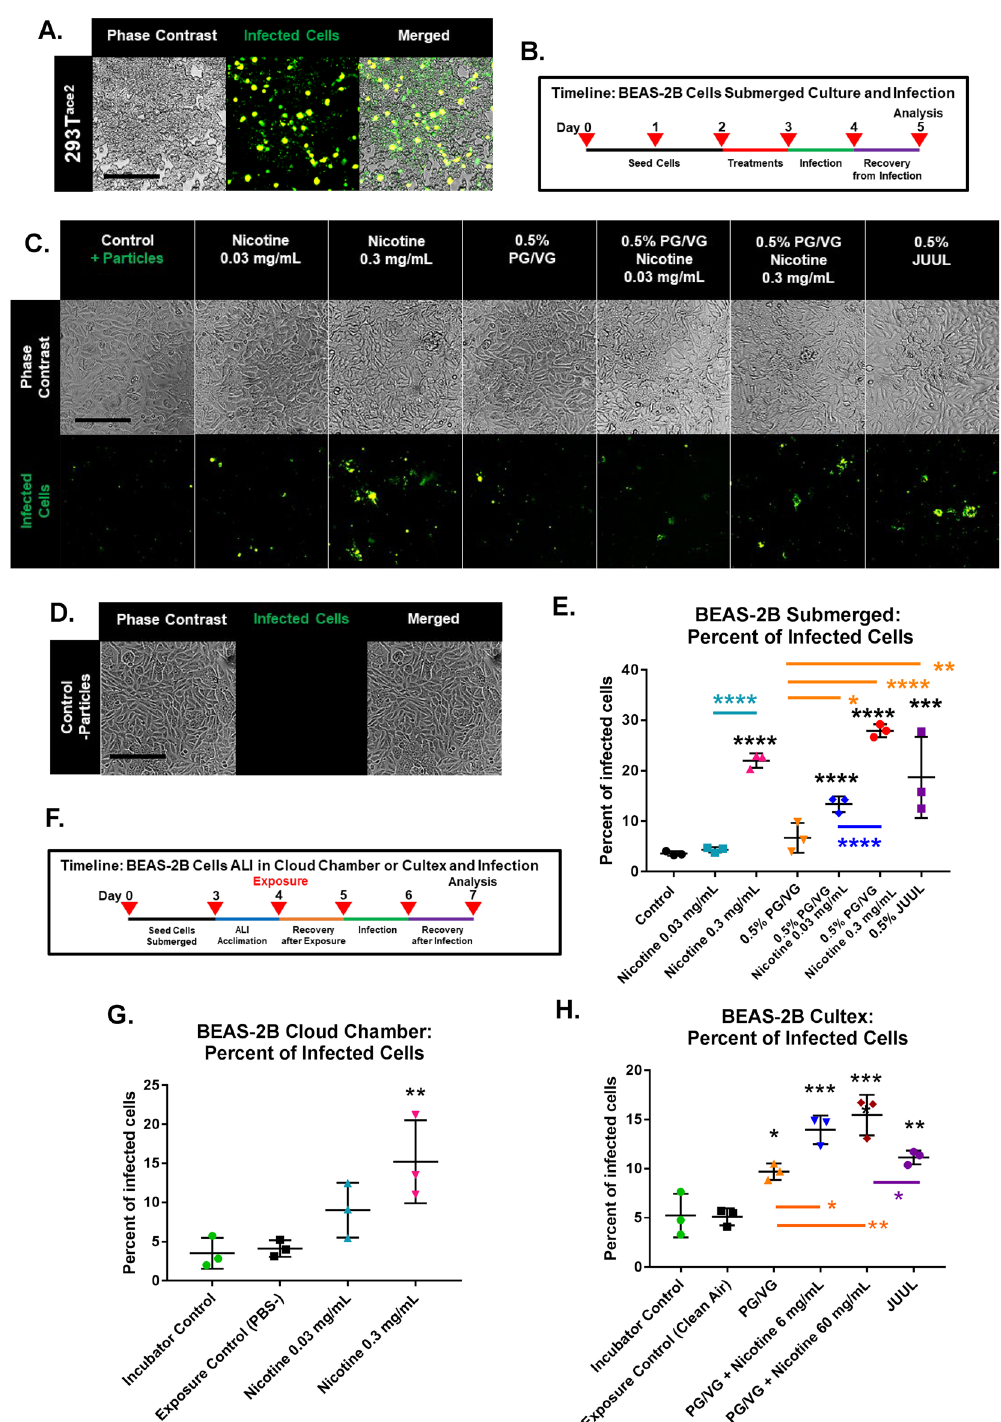
Figure 4. JUUL aerosols and nicotine increased infection after submerged treatment or ALI exposure to aerosols. ( A ) 293T ACE2 cells infected by SARS-CoV-2 viral pseudoparticles. Infected cells express ZsGreen. Scale bar = 250 µm. ( B ) Experimental treatments in submerged culture followed by infection. ( C–E ) Micrographs and flow cytometry showing infection of cells treated 24-h with EC chemicals or JUUL fluid then infected for 24 h. ( C, D ) Micrographs showing ( C ) cells infected with pseudoparticles and ( D ) uninfected cells. ( E ) Percent of infected cells determined by flow cytometry. Scale bars in C and D = 250 µm. ( F ) Experimental treatment used with cells exposed at the ALI in a cloud chamber or a Cultex system, then infected with viral pseudoparticles for 24 h. ( G ) Percent of infected cells after cloud chamber exposure to 1 puff of PBS (control), 0.03 mg/mL nicotine, or 0.3 mg/mL nicotine, followed by 24 h of exposure to pseudoparticles. ( H ) Percent of infected cells after exposure to 10 puffs of clean air or EC aerosols, followed by 24 h of exposure to pseudoparticles. Exposure was at the ALI in a Cultex system. All graphs are plotted as the mean ± standard deviation of three independent experiments. Box-Cox transformed data were analyzed using a one-way ANOVA followed by Tukey’s test to compare means. Black * = significantly different than the control in ( E ) or the exposure control in ( G ) and ( H ). Colored * and lines = significantly different groups. * p < 0.05, ** p < 0.01, *** p < 0.001, **** p <